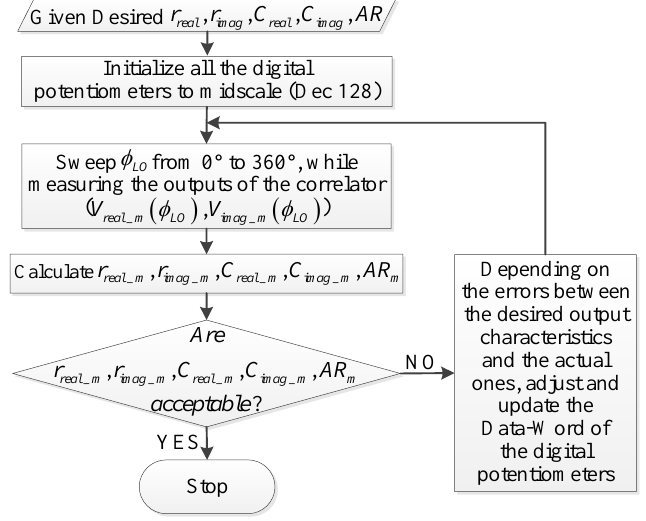
Figure 5. The flowchart for the DC offsets and the quadrature amplitude calibration.